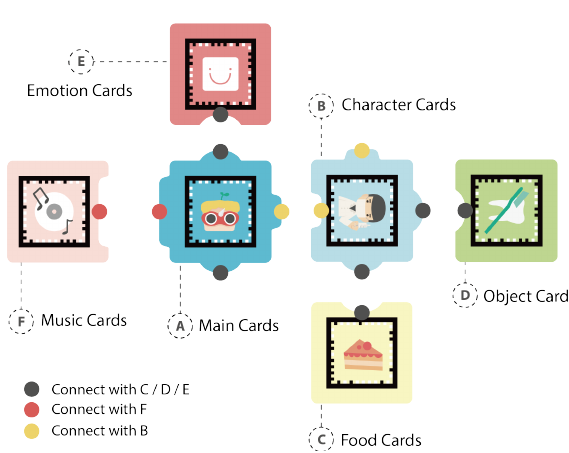
Figure 7. The physical components design of an AR educational training approach project for Autism